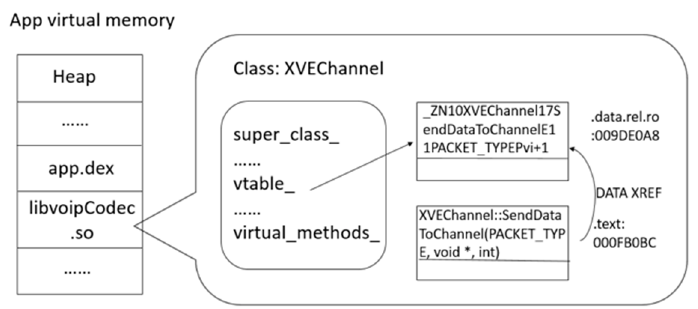
Figure 2. The application’s memory layout without hooking a method.